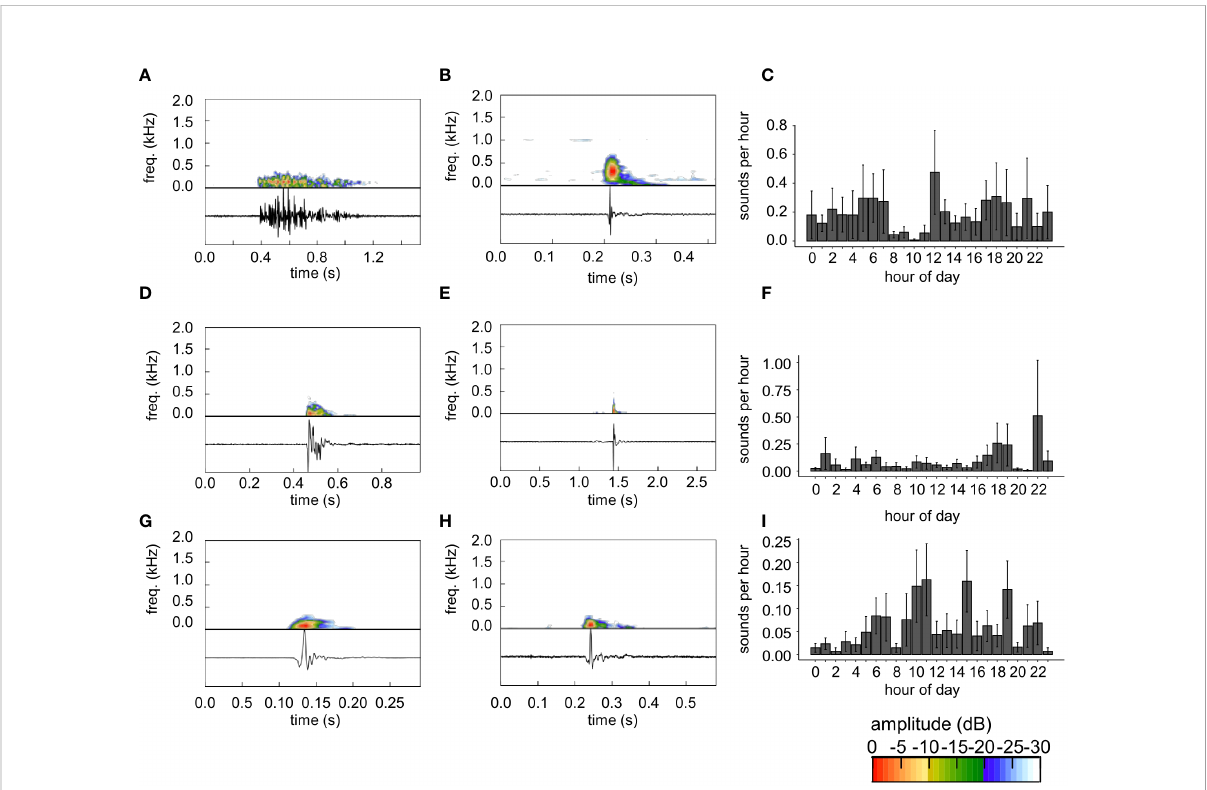
FIGURE 3 (A, B, D, E, G, H) Low frequency sounds and (C, F, I) diel detection rates of low frequency sounds. Oscillograms and spectrograms of sounds are shown in the panels in the left and middle columns. Low frequency sounds used as templates: (A) LF1, (D) LF4, (G) LFP. Low-frequency sounds detected by (B) LF1, (E) LF4, and (H) LFP. Note low frequency sounds in (A) and (D) do not appear to be a common stereotyped sound and (B, E) sounds with the highest detections are not similar sounds. In contrast, (G) template 27 detects similar, (H) stereotyped low frequency pulses. Diel detections (mean hourly detections ± SE) from (C) template LF1, (F) LF4, and (I) LFP. Diel detection rates (C, F, I) are the mean ± SE hourly detection rate among all reefs (2017 and 2018) from each template. Note differences in time scales for sound fi gure panels. Color scale bar shows relative amplitude (dB) of frequencies depicted on the